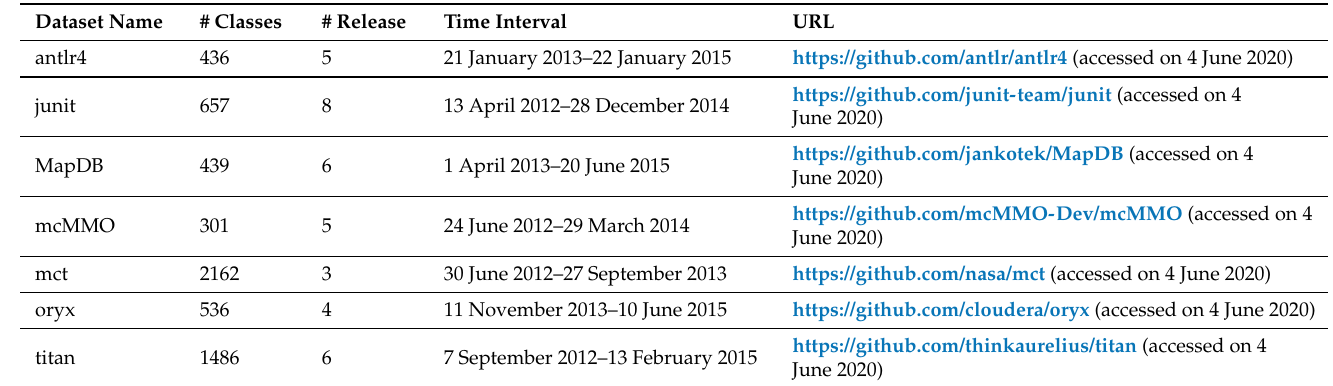
Table 3. Summary of the